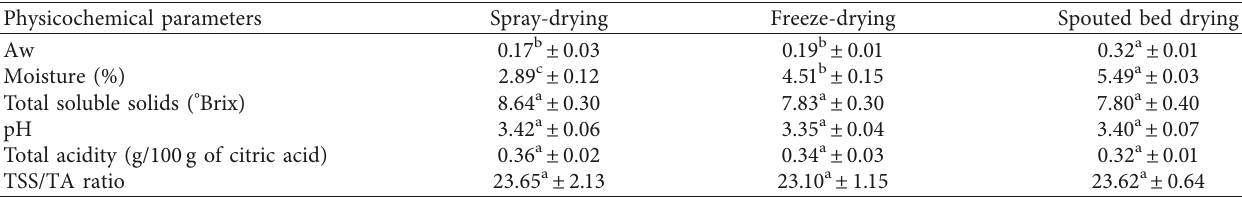
Table 2: Physicochemical characterization of acerola-ceriguela (60% acerola and 40% ceriguela) mixed pulp obtained by spray-drying, freeze-drying, and spouted bed drying.